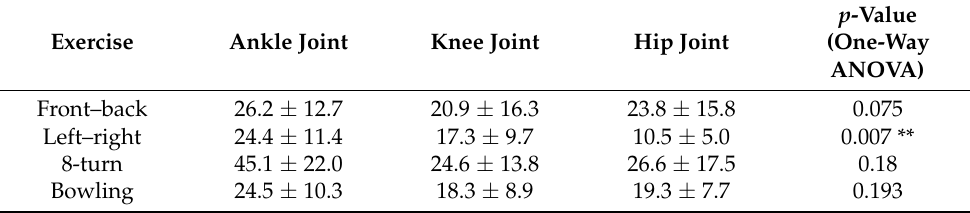
p -Value (One-Way ANOVA)